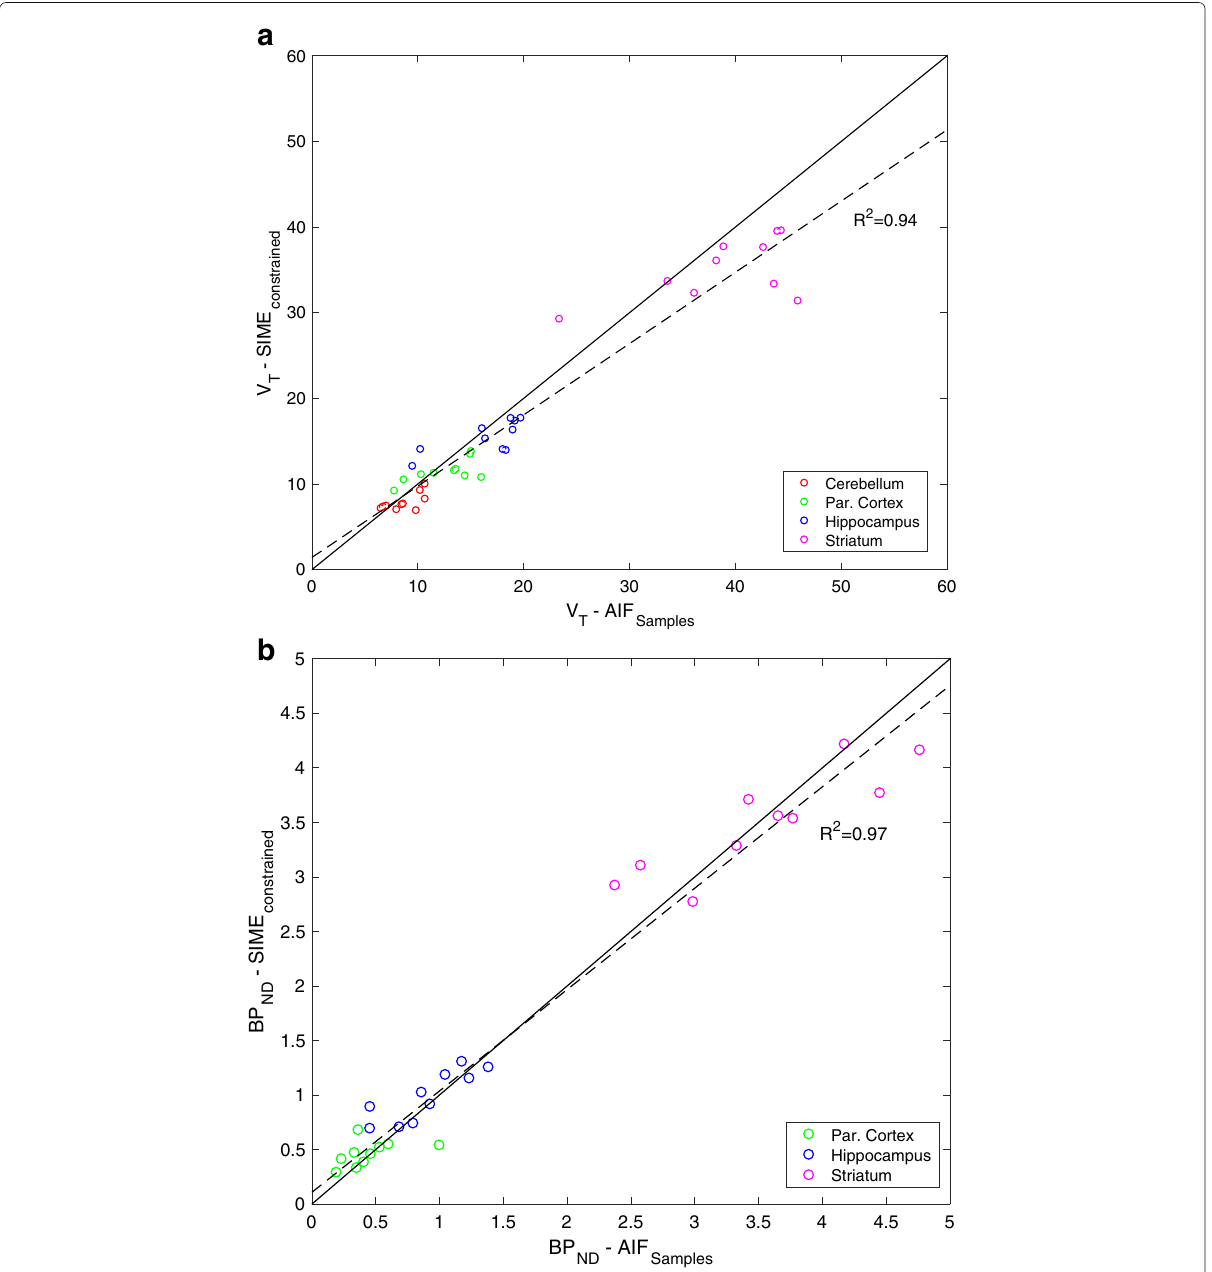
Fig. 8 a V T and b BP ND estimated using SIME constrained compared to V T and BP ND determined by AIF from arterial samples. Results from each scan are shown per each ROI. A linear function was fitted to the data points and plotted together with the line of